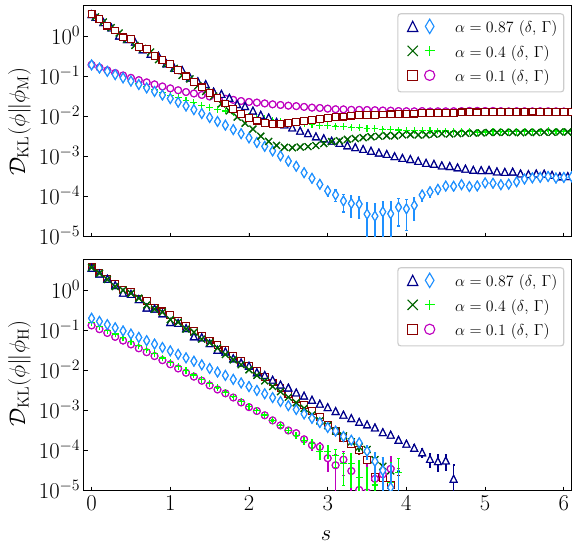
φ R ) (in logarithmic scale) for Figure 1. Evolution of ( φ D KL k R = M (top panel) and R = H (bottom panel). Symbols repre- sent MD simulation results for coe ffi cients of restitution α = 0 . 1, 0 . 4, and 0 . 87, starting from the initial conditions δ and Γ . The error bars are smaller than the size of the symbols, except when φ R ) . 10 − 4 . Symbols for s & 5 are discarded in the ( φ D KL k bottom panel because they appear as purely noise, representing values that are out of the precision of the numerical scheme.